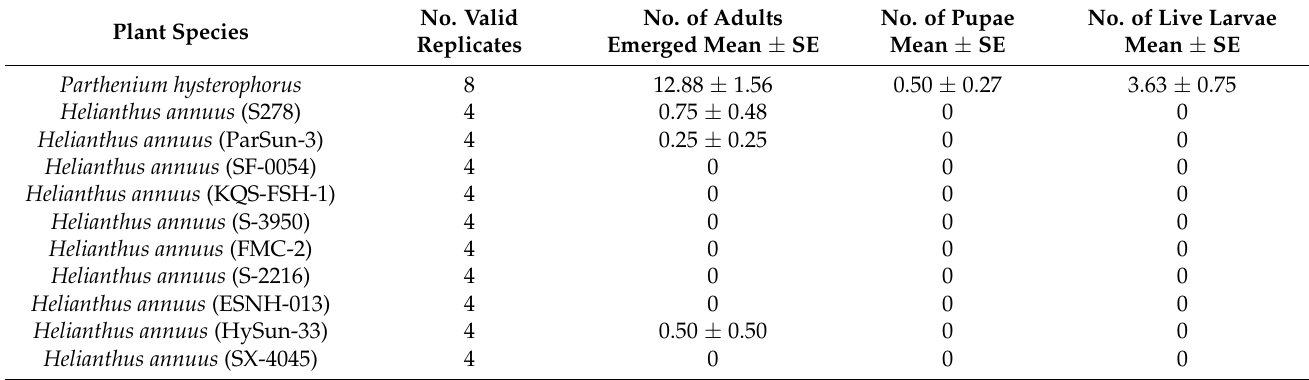
Table 2. Development of Listronotus setosipennis larvae arising from 30 eggs per replicate on sunflower cultivars that are considered important in